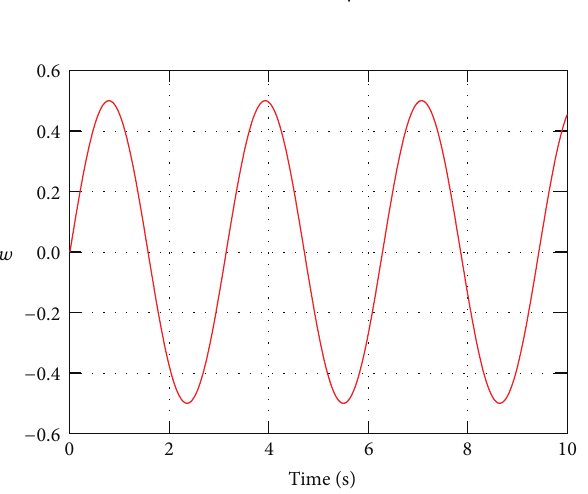
Figure 4: Time history of 𝑘(𝑥) .